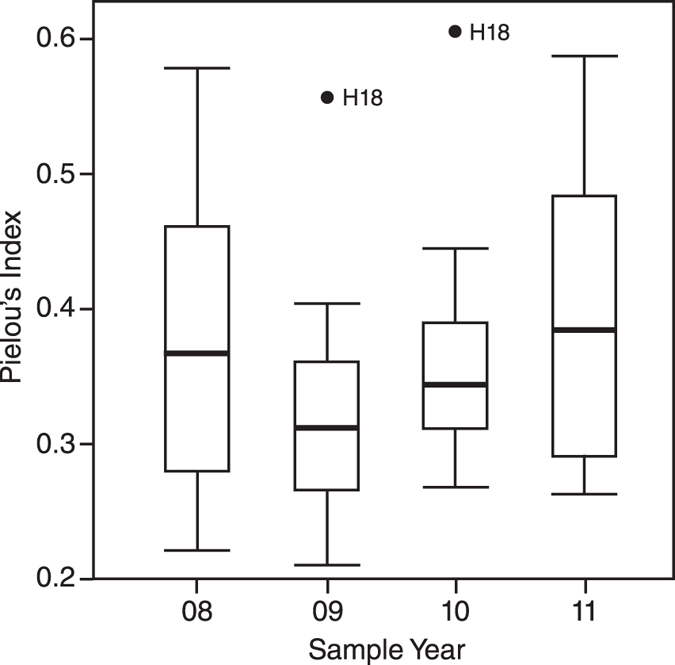
Boxplot of Pielou’s Evenness Index for the four sampling intervals.Band inside box = mean. Whiskers = +/−1.5*Interquartile range (IQR) and points represent sample sites that fall outside whiskers.